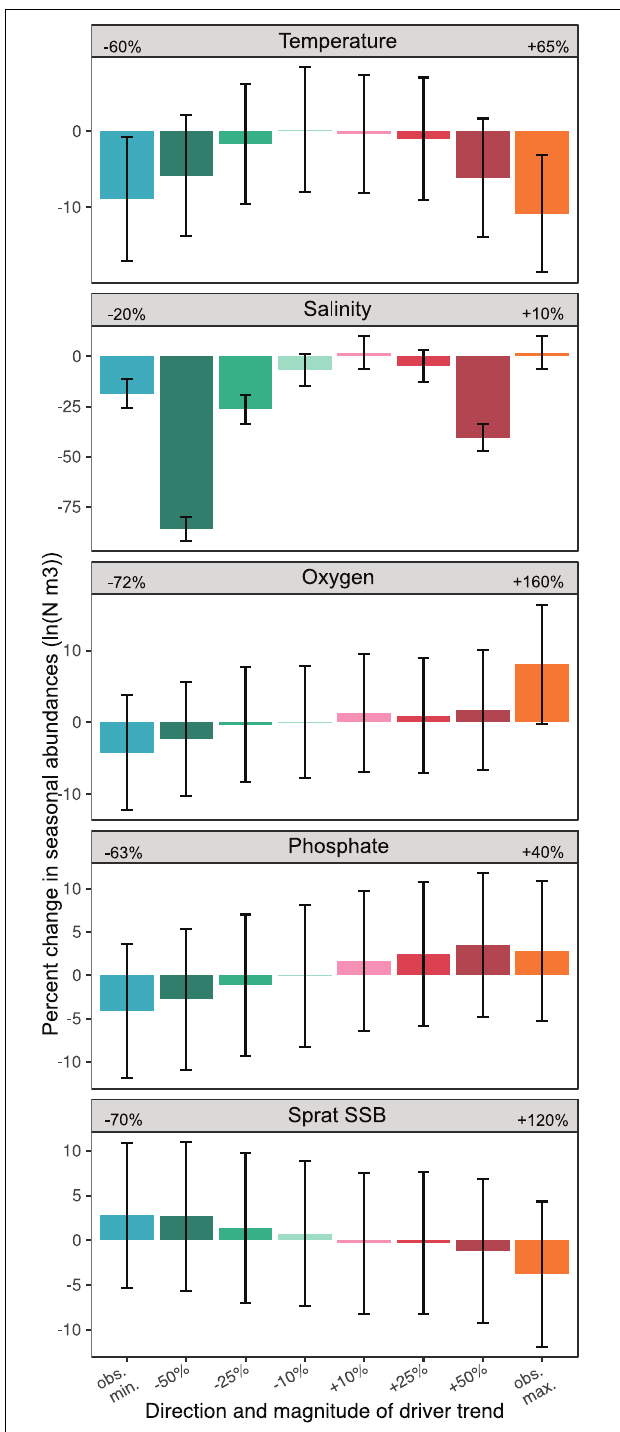
FIGURE 3 | Effect size of single environmental changes. The percent change of mean seasonal abundances over the course of 10 years under eight different trend scenarios is presented for each stressor. Percent changes are calculated for each of the 1000 Monte Carlo simulations and then averaged. The error bars represent the standard deviation. The numbers next to the stressor names represent the maximum observed negative and positive deviations from the time series